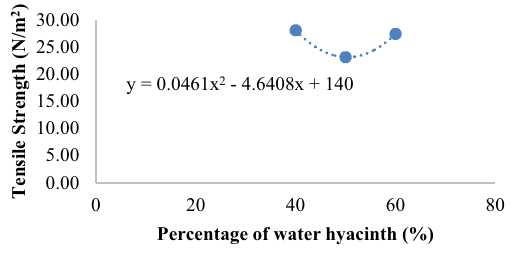
Fig. 1 The correlation between tensile strength and the percentage of rice straw contents in organic mulch sheet